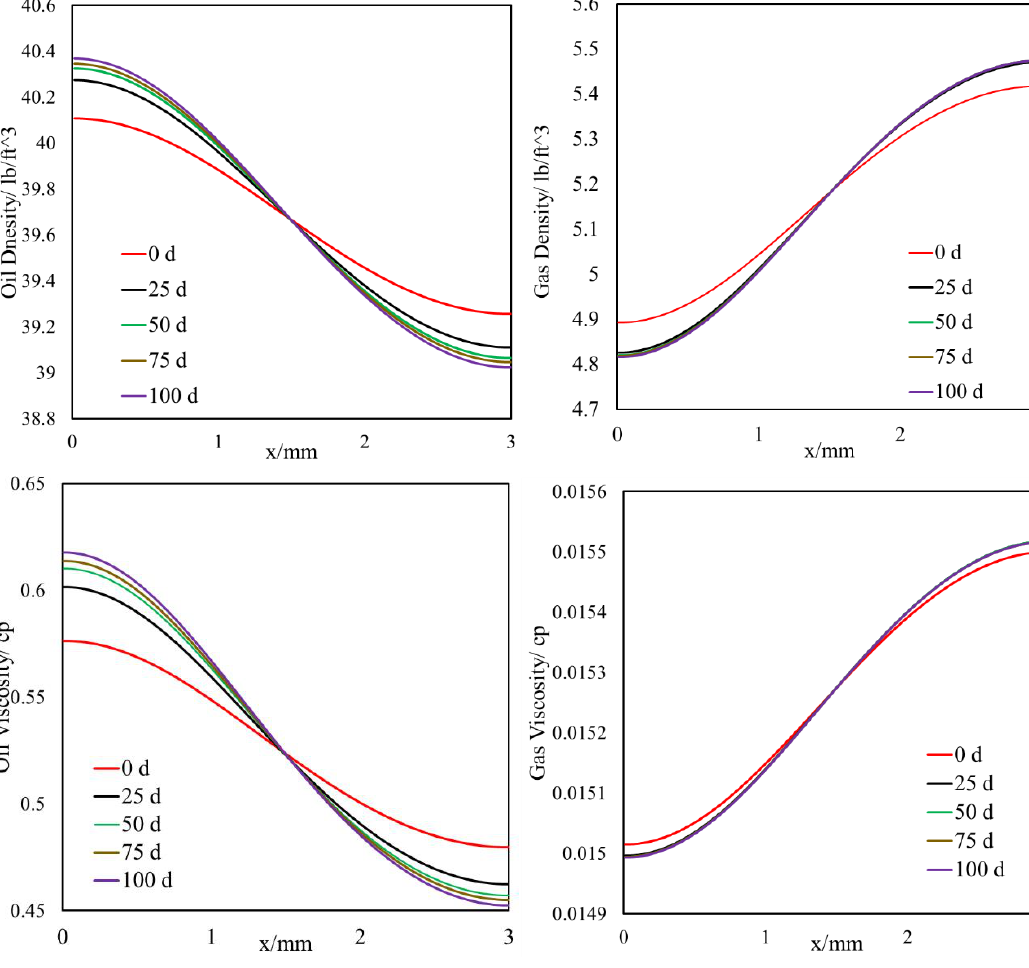
Figure 9. Oil and gas density/viscosity profile s at different times, Bakken shale oil.